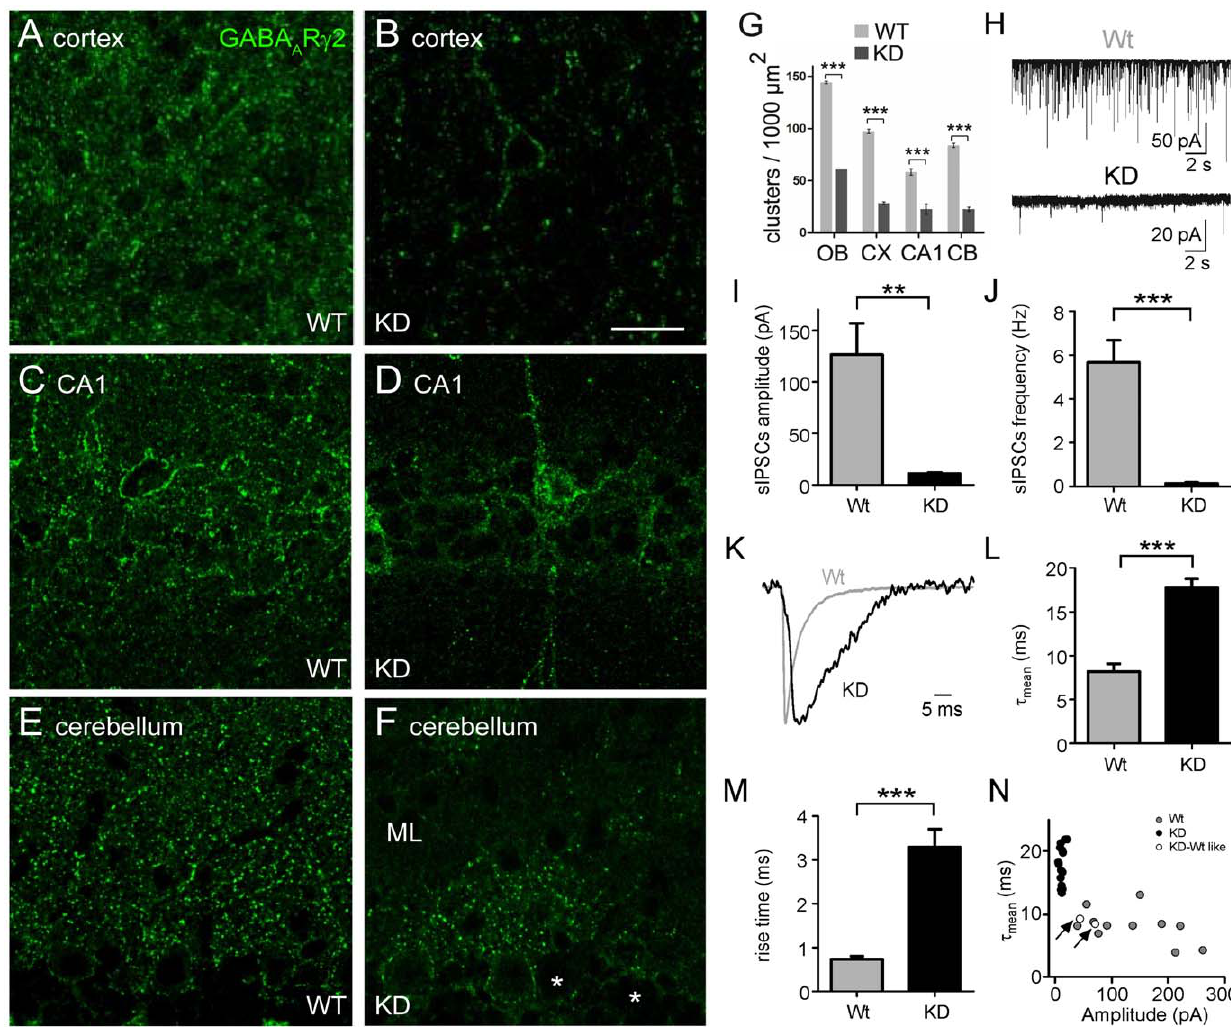
Figure 4. Mosaic expression of the c 2 subunit in the brain of c 2 KD mice. A–F, Representative images of sensorimotor cortex, hippocampal CA1 and cerebellum showing immunofluorescence labeling for the c 2 subunit. Note the reduced punctate labeling in c 2 KD brains as compared with WT. In c 2 KD cerebellum the co-existence of c 2-positive and c 2-negative PCs (asterisks) results in an uneven distribution of synaptic clusters in the molecular layer (ML). G, Quantification of c 2-positive puncta in brain regions of c 2 KD mice and WT littermates (***, p , 0.001; unpaired t -test; n=3 mice per group). OB, olfactory bulb (external plexiform layer); CX, sensorimotor cortex (layer V); CA1, CA1 ( stratum radiatum ); CB, cerebellum (molecular layer). H, Example traces of sIPSCs recorded from PCs in WT and c 2 KD mice. I, Quantitative analysis showing dramatically